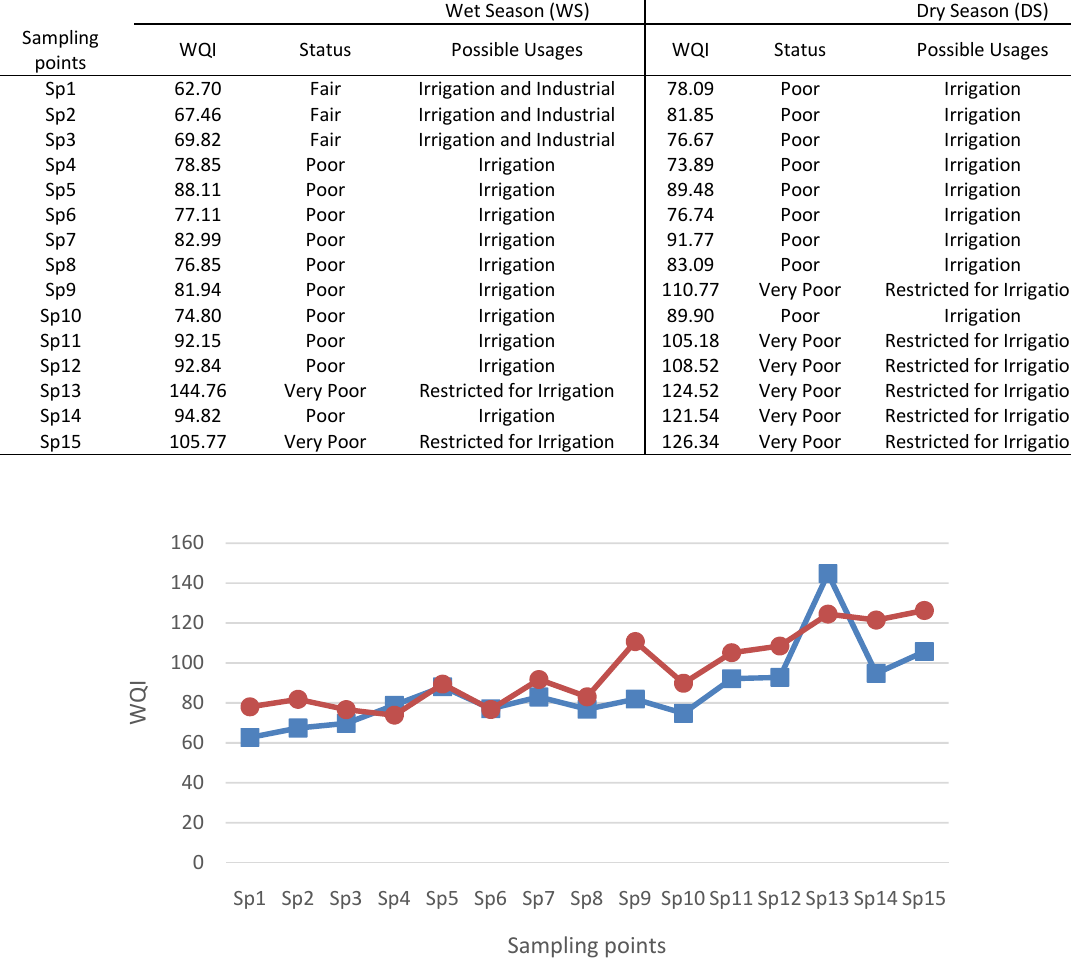
Fig. 2: Spatial and seasonal variation in WQI values along Galma Fig 2: Spatial and seasonal variation in WQI values along Galma River